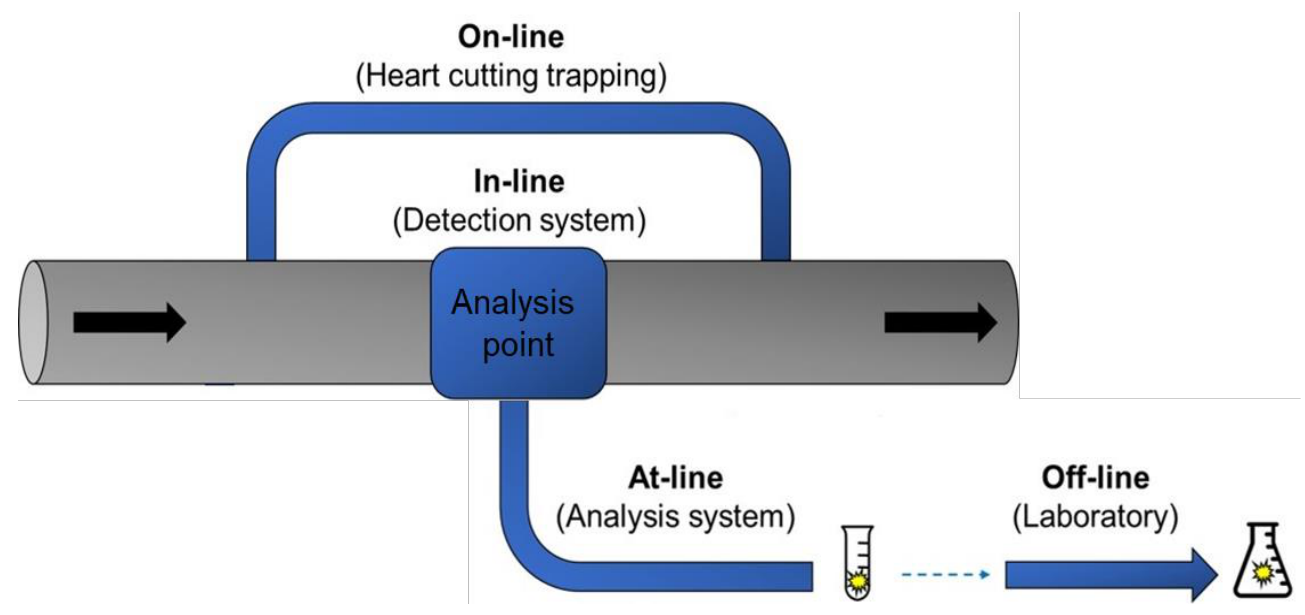
Figure 1. Classification of coupling forms with the detection system.